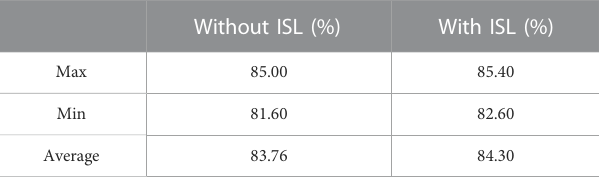
TABLE 2 Statistical fi xing rate with and without ISL